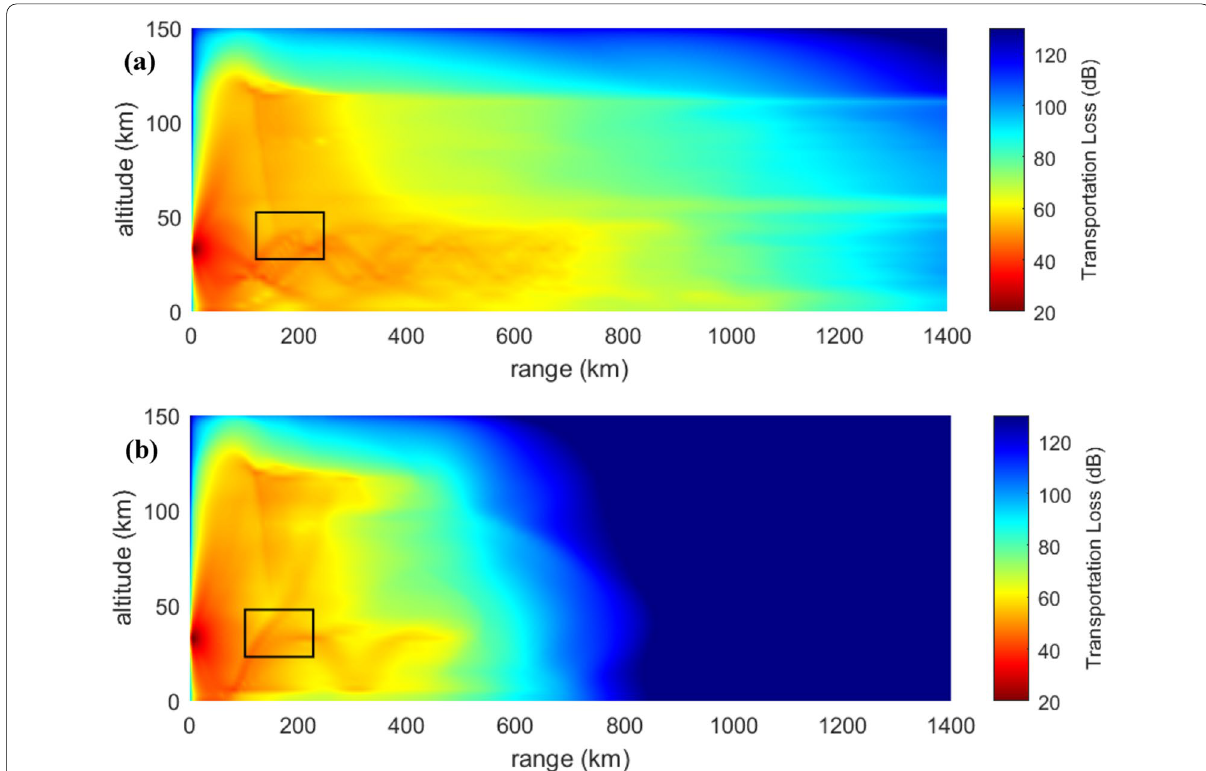
Fig. 5 a Distribution of the transportation loss of the infrasound signal in the direction of Yunnan Station obtained using the NPE method. The transportation of the Yunnan array is 74 dB; and b distribution of the transportation loss of the infrasound signal in the direction of Xinjiang Station obtained using the NPE method. The transportation loss of the Xinjiang array is 175